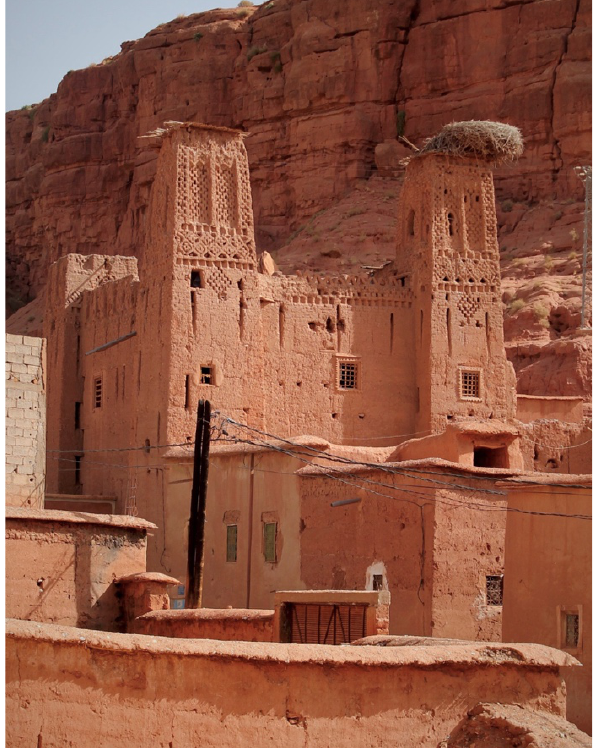
Figure 4. Tighremt Aït Aicha (Bou Taghrar),